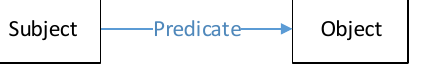
Fig. 1. RDF minimal information unit: a